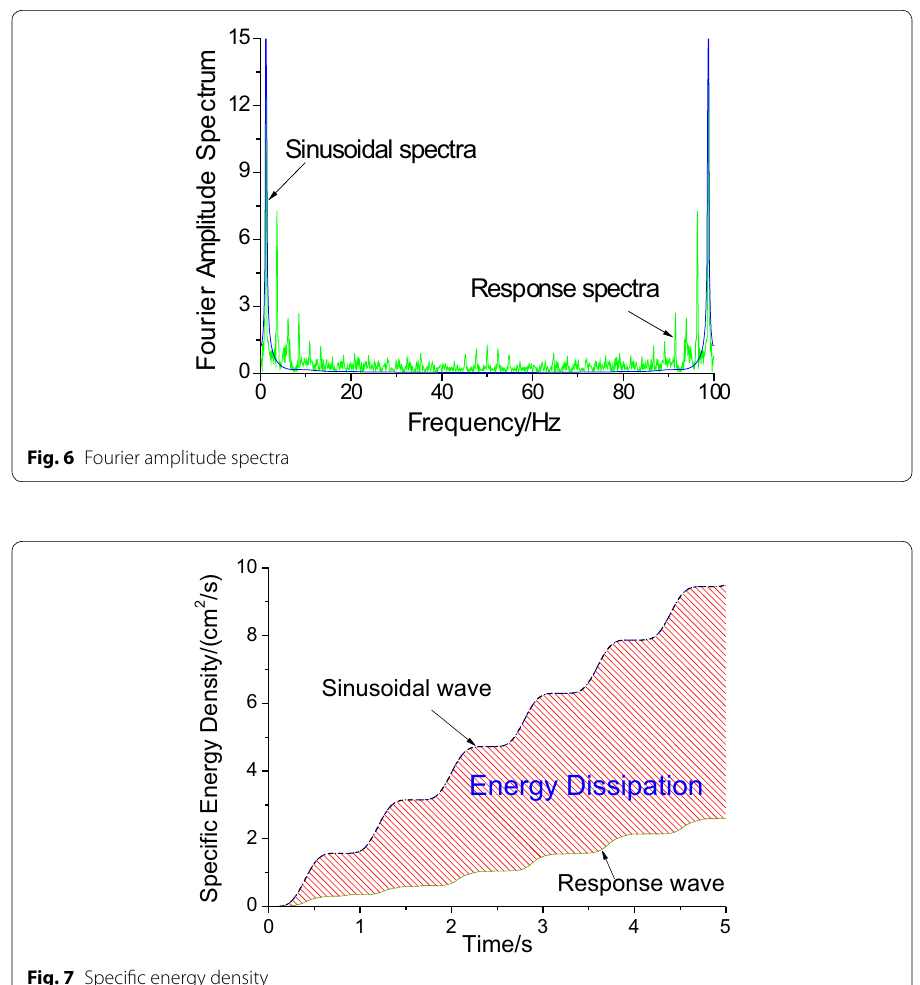
Fig. 7 Specific energy